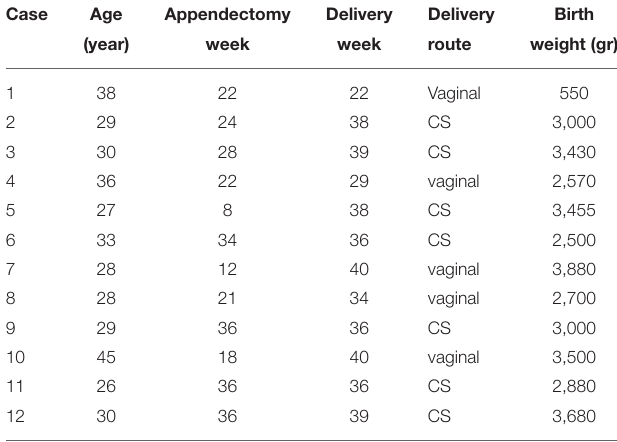
TABLE 1 | Characteristics of pregnant women who underwent an